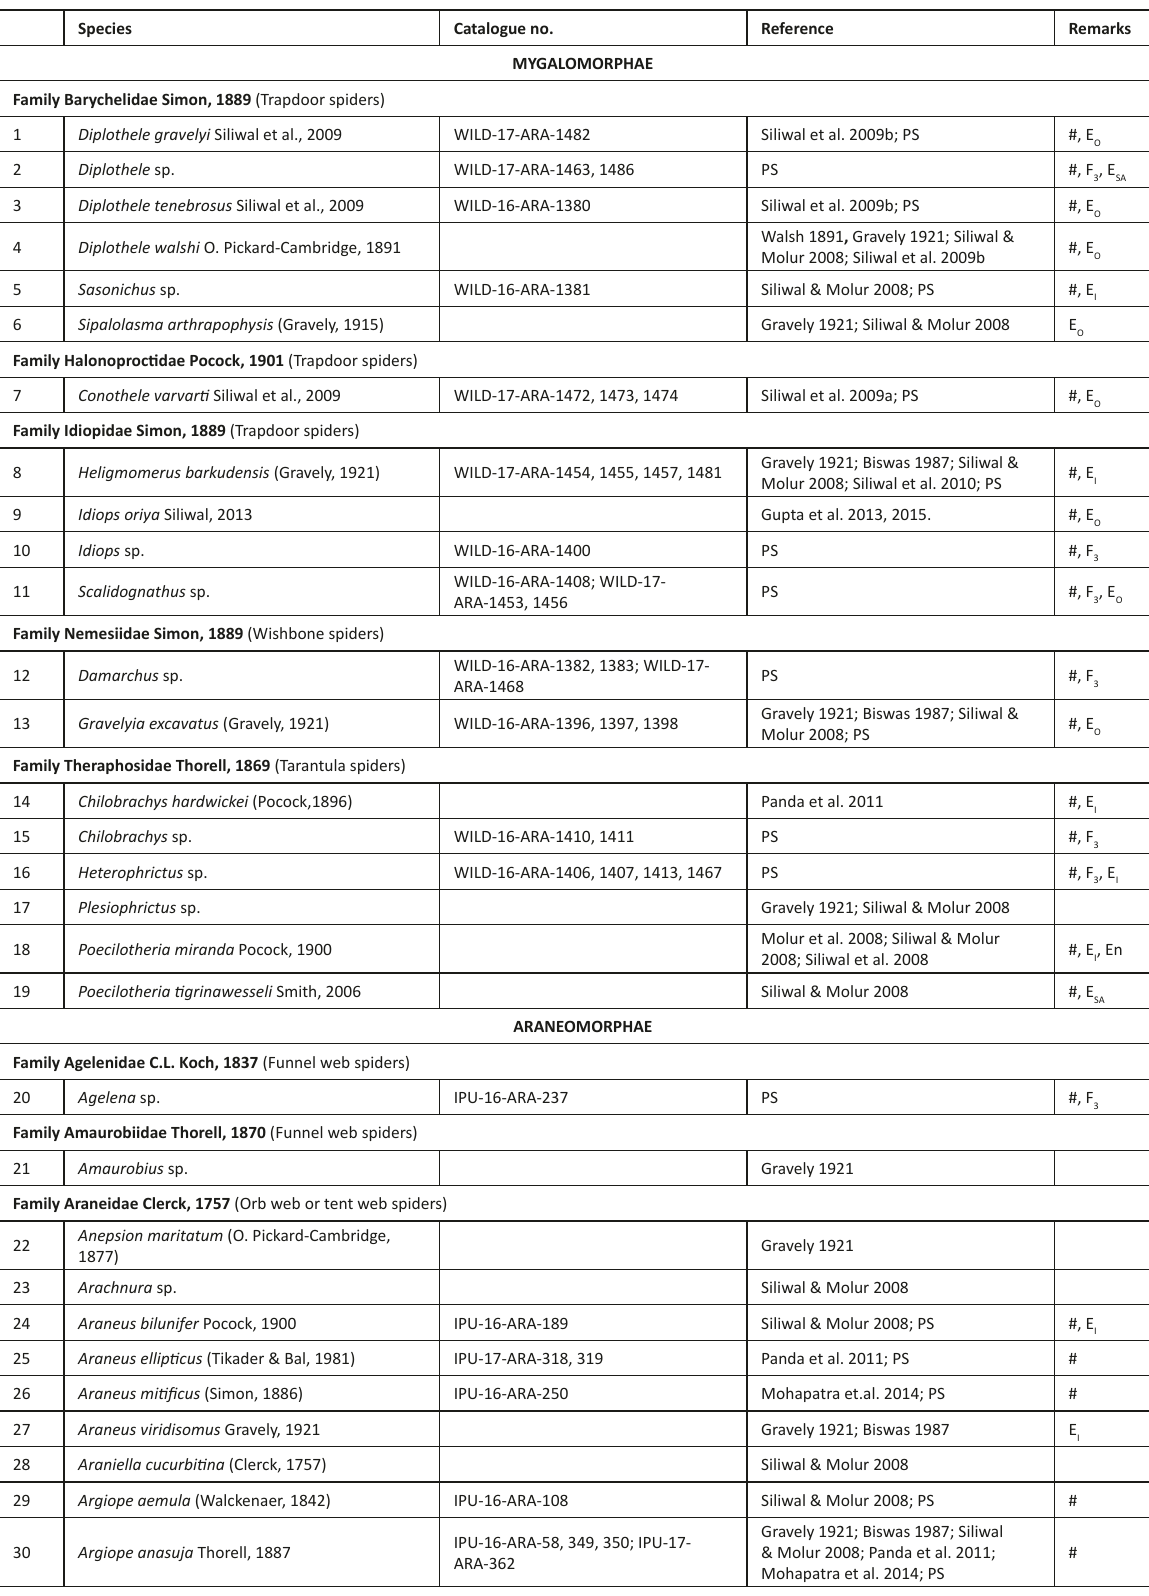
Table 2. Checklist of spiders of Odisha